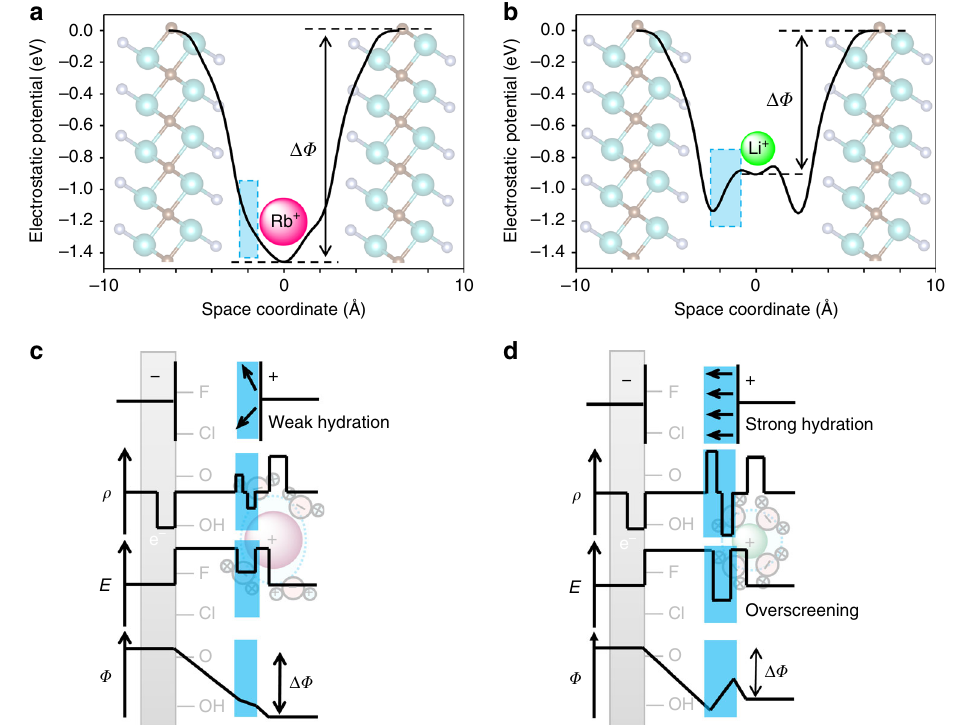
Fig. 3 Negative dielectric constant of con fi ned water. a , b Theoretical calculation for the electrostatic potential pro fi le of Rb + - and Li + -intercalated Ti 2 CT x · n H 2 O. c , d Schematic illustrations of the charge density ( ρ ), the strength of the electric fi eld ( E ), and the electrostatic potential ( Φ ) of weakly hydrated cations and strongly hydrated cations con fi ned in a microslit supercapacitor as a function of the spatial coordinates. The arrows indicate the direction of the water dipole oxygen and hydrogen atoms primarily accumulate in the central plane of the microslit (away from the MXene interface). We presume that there is only a weak interaction between water and the MXene surface. Osti et al. 26 also reported that water in pristine Ti 3 C 2 T x has bulk-like characteristics, which indicates the weak interaction between water and MXene. 3D-RISM calculations were then conducted for cation-